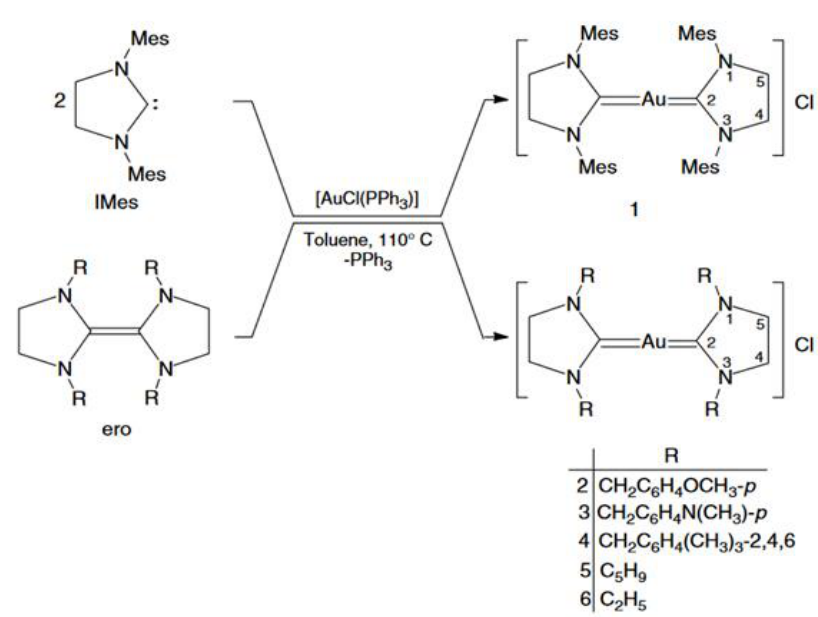
Figure 6. Synthesis of gold(I)-NHC complexes used for studies [58].